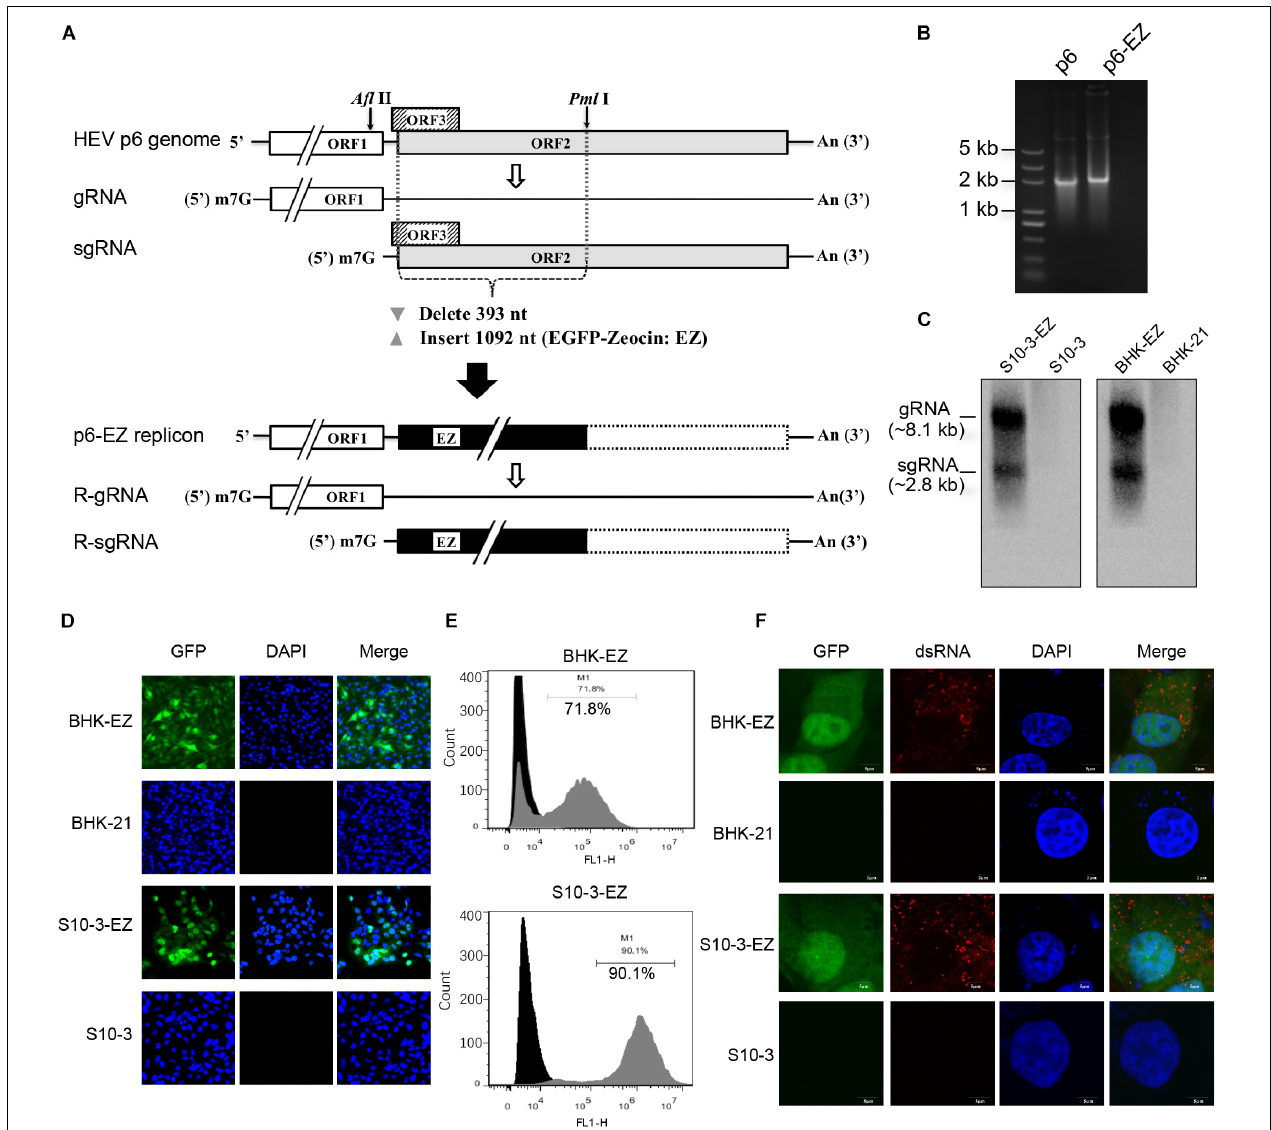
FIGURE 1 | Establishment of two stable persistent HEV RNA replicon cell lines BHK-EZ and S10-3-EZ. (A) A schematic diagram of HEV replicon p6-EZ. The HEV ORF1 is intact, whereas only the first 11 nt of the ORF3 remains; the first 393 nt of the ORF2 are replaced by a gene (1,092 nt) encoding EGFP-zeocin (EZ) followed by a termination codon. Open rectangles: HEV coding regions; black rectangle: EGFP/zeocin (EZ) coding region; dashed-line rectangle: residual ORF2 gene (not translated). (B) Agarose gel electrophoresis showing the transcribed RNAs of p6 and p6-EZ clones. (C) Northern blot analyses of positive-strand viral RNA detected in HEV persistent replicon cell lines S10-3-EZ and BHK-EZ. Total RNAs extracted from BHK-EZ and S10-3-EZ and their respective parental cell lines were probed with RNA specific to the 7182–7240 nt fragment of p6-EZ. The upper bands are full-length p6-EZ RNAs, and the lower bands are subgenomic RNAs. (D) The expression of EGFP was observed by fluorescence microscopy in S10-3-EZ and BHK-EZ cells. (E) Detection of GFP-positive cell rate of HEV persistent replicon cell lines S10-3-EZ and BHK-EZ by FACS. (F) Immunofluorescence (IFA) of S10-3-EZ and BHK-EZ or respective parental cell lines, stained with anti-dsRNA monoclonal antibody, to confirm viral